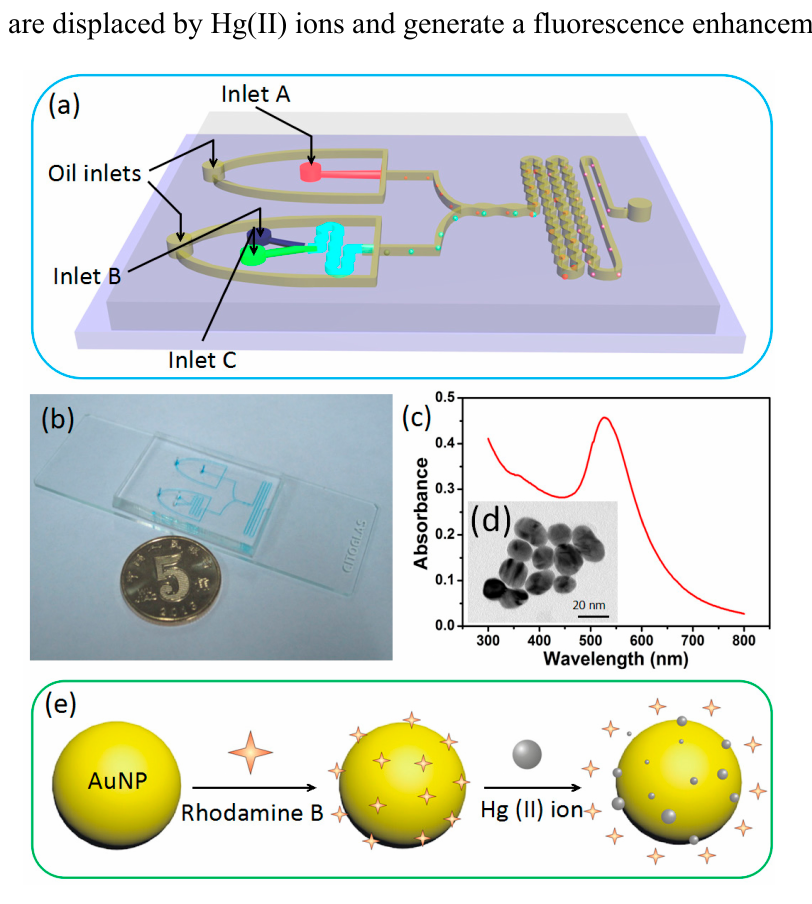
Figure 1. ( a ) Three-dimensional model of the microfluidic droplet mixer; ( b ) Photograph of the microfluidic device; ( c ) UV-Vis absorption spectrum and ( d ) TEM image of the produced gold nanoparticles (AuNPs); ( e ) The mechanism of RB-AuNPs-based Hg(II) ion